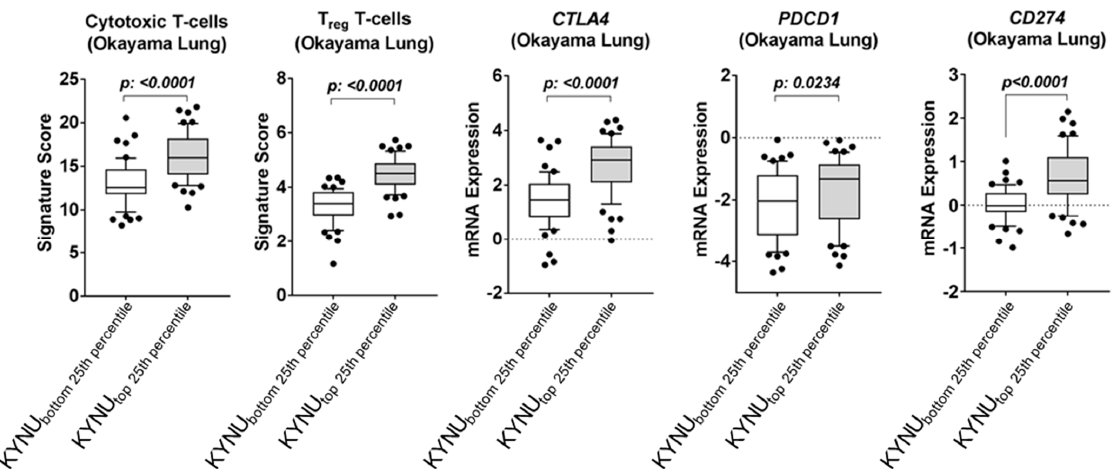
Figure A4. Association between KYNU mRNA expression and gene-based signatures of immune infiltrates and immune checkpoint blockade related genes. Box and whisker plots illustrating the distribution of gene-based signatures reflective of cytotoxic T-cells, regulatory T cells, as well as immune checkpoint blockade-related genes CD274 (PDL-L1), PDCD1 (PD1), and CTLA4 in the Okayama Lung Cancer [24] gene expression dataset for LUAD tumors stratified by KYNU mRNA expression into the bottom and top 25th percentiles. The center line and bottom/upper bounds indicate median and 1st/3rd quartiles, respectively. Whiskers represent the 5th and 95th percentile of values. Statistical significance was determined by two-sided Wilcoxon rank sum test. Gene based signatures of immune infiltrates are based on Bindea et al. [36].